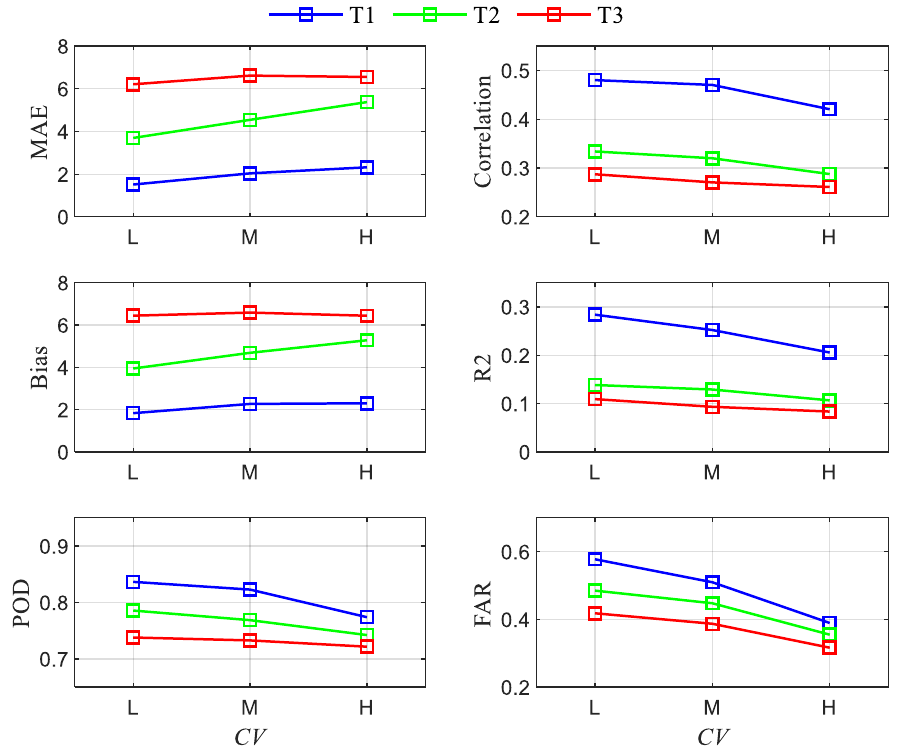
Figure 11. Comparison of rainfall nowcasting skills shown in Figure 7 under different lead times and rainfall temporal Moran’s I values.